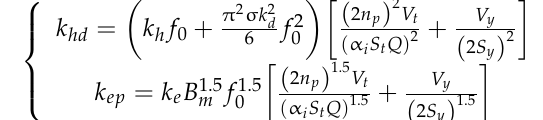
0 Figure 4. Fundamental loss comparison between FEA and the analytical method at different speeds and torques. Figure 5. Difference of motor loss between the FEA method and the proposed analytical method at different speeds and torques. Figure 4 shows that the fundamental loss of the PMSM in the proposed analytical method could match well with the simulation results of the FEA, and Figure 5 shows that the loss calculation error